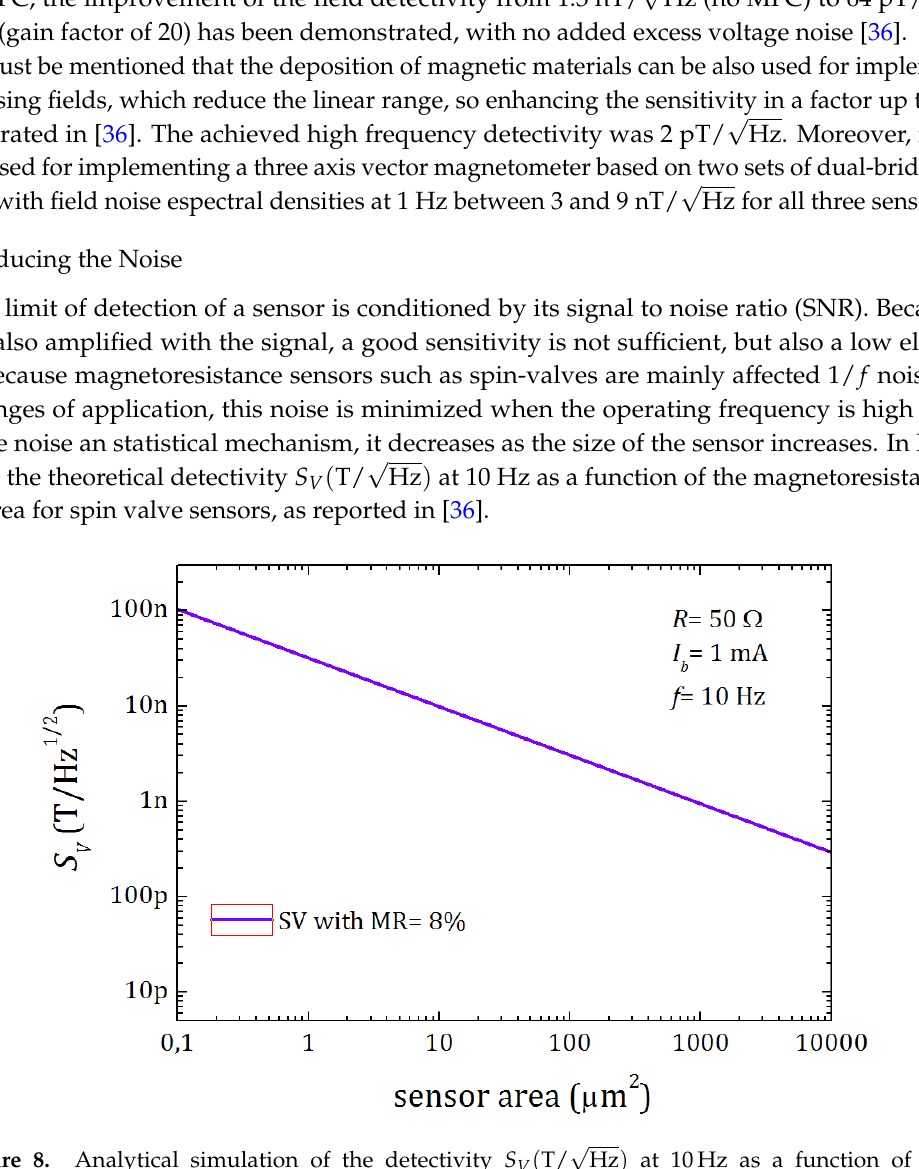
Figure 8. Analytical simulation of the detectivity S V ( T/ √ Hz ) at 10Hz as a function of the magnetoresistance and sensor area for a spin valve